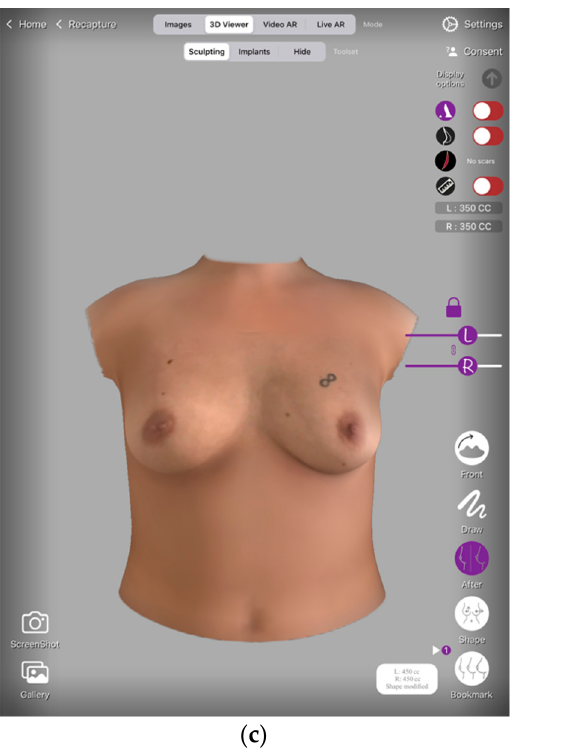
Figure 1. ( a ) Pre-operative photograph of a 27-year-old patient. ( b ) Breast augmentation simulation allows the patient to choose their breast implant, implant positioning (dual plane in this case), and surgical approach. ( c ) 3D breast augmentation simulation allows the provider to easily choose the implant volume with the patient. ( d ) Post-operative photograph of the same patient at the one-year follow-up.